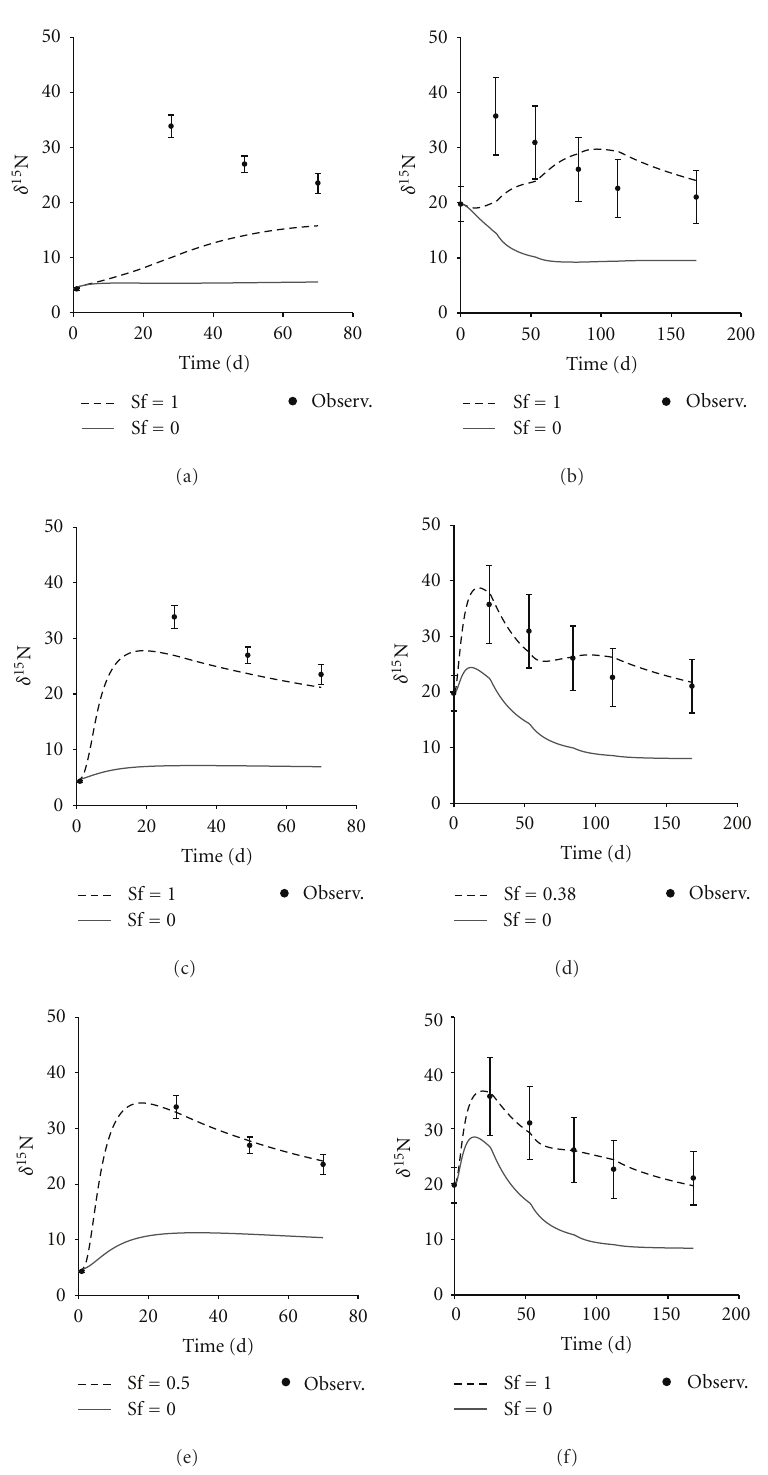
Figure 3: Simulated change of plant δ 15 N after input of 15 N-labelled decomposing residue in the residue application (RA; a, c, e) and full interaction experiments (FI; b, d, f), when the residue is considered to consist of (a, b) a single fraction with uniform C:N and δ 15 N, (c, d) two fractions with di ff erent C: N but uniform δ 15 N, and (e, f) two fractions with di ff erent C:N and δ 15 N. Simulations were conducted with proportionally equal N uptake from soil inorganic N sources (Sf = 0) and by optimising the N source factor in the simulations. Vertical bars indicate the standard error of mean for the observations ( n = 8 and n = 4 for the RA and FI experiments, resp.). For explanations and parameter values, see text and Table